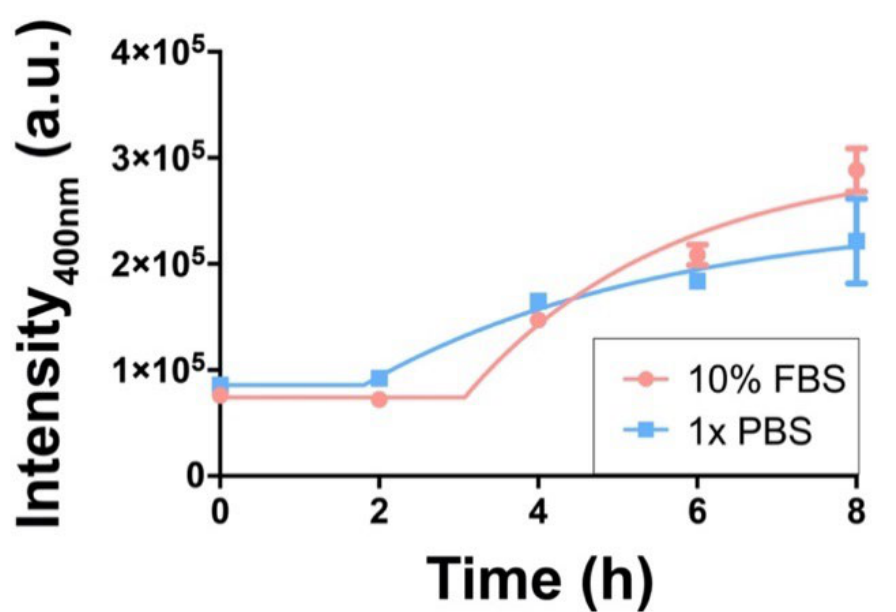
Figure 4. Chloroquine release kinetics from liposomes incubated at 37 °C; red: in 10% FBS (r 2 = 0.96); blue: in 1x PBS (r 2 = 0.91); ex: 320 nm; em: 400 nm. Data points represent mean +/ − SD ( n = 3).